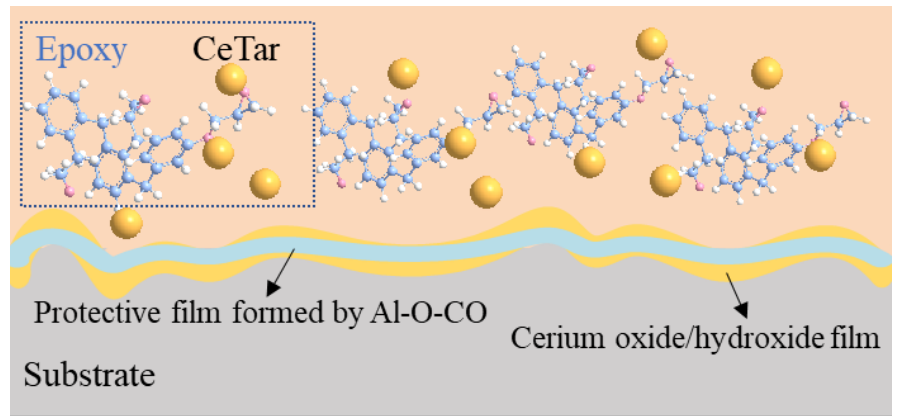
Figure 16. Schematic diagram of protection mechanism of the epoxy coating with CeTar on alumi- num